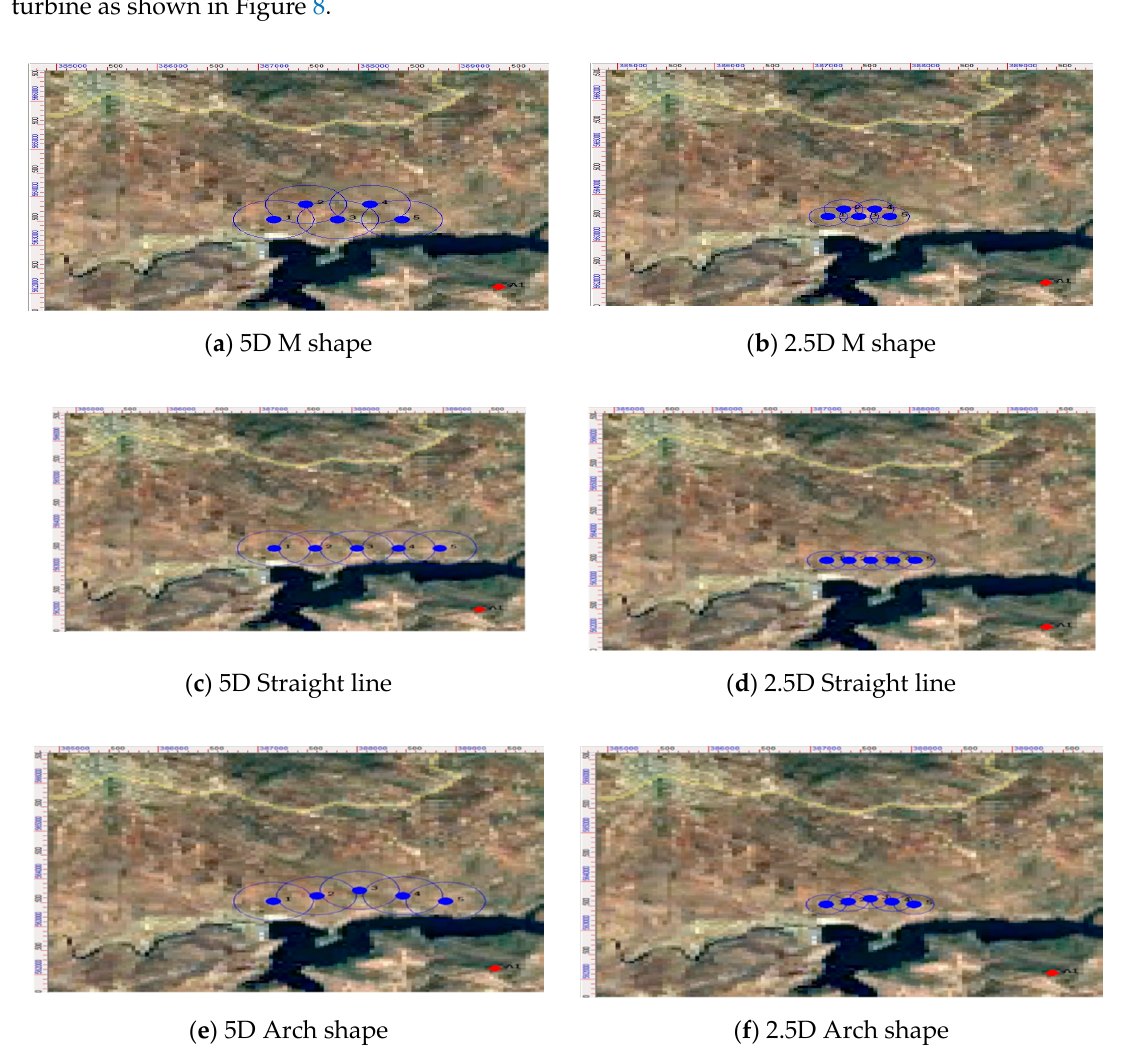
Figure 8. Wind turbines layouts and spacing.